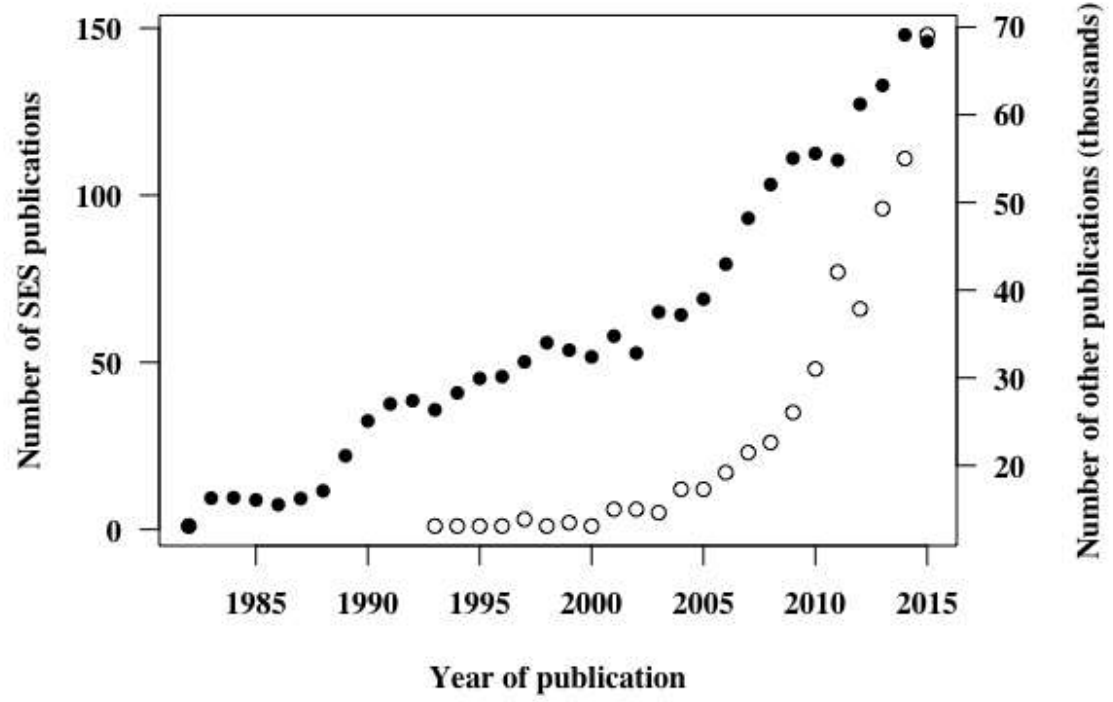
Fig. A1.1. Frequency of social-ecological (SES; o) and other (  ) papers published over